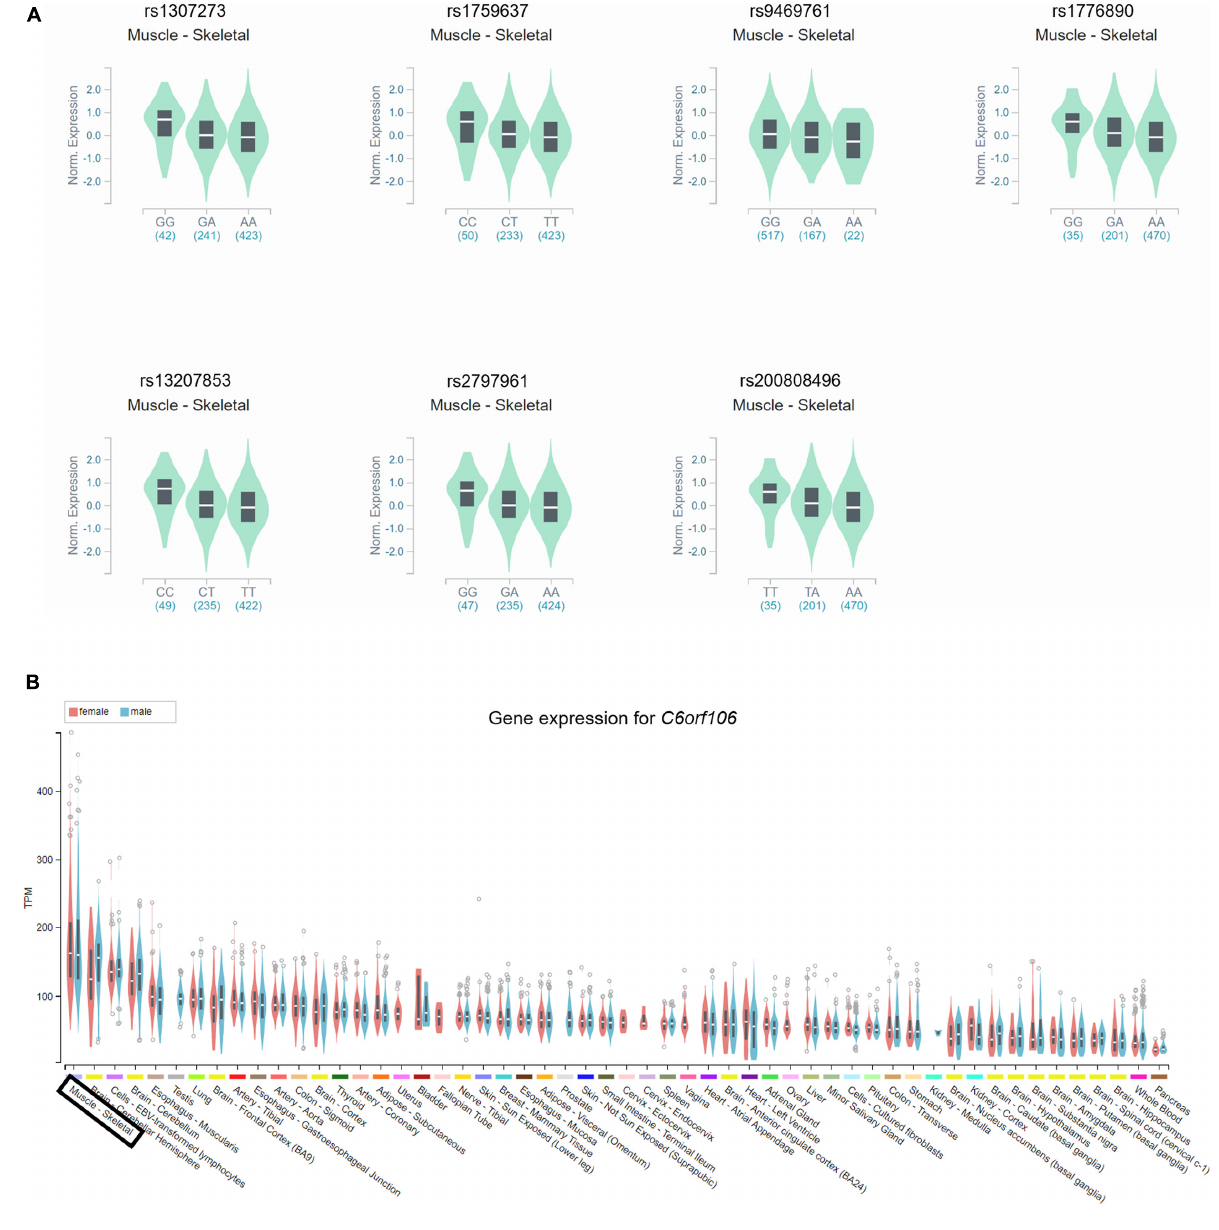
FIGURE 2 | Identification of the gene expression of the C6orf106 gene and seven novel SNPs in eQTL. The gene expression of each genotype in the skeletal muscle was presented using GTEx Portal and showed statistical significance. (A) Expression of each genotype of rs1307273, rs1759637, rs9469761, rs1776890, rs13207853, rs2797961, and rs200808496 in the RP11-513I15.6 region. All of the seven variants showed statistical significance reaching P < 10 − 4 . (B) Gene expression of the C6orf106 gene in the skeletal